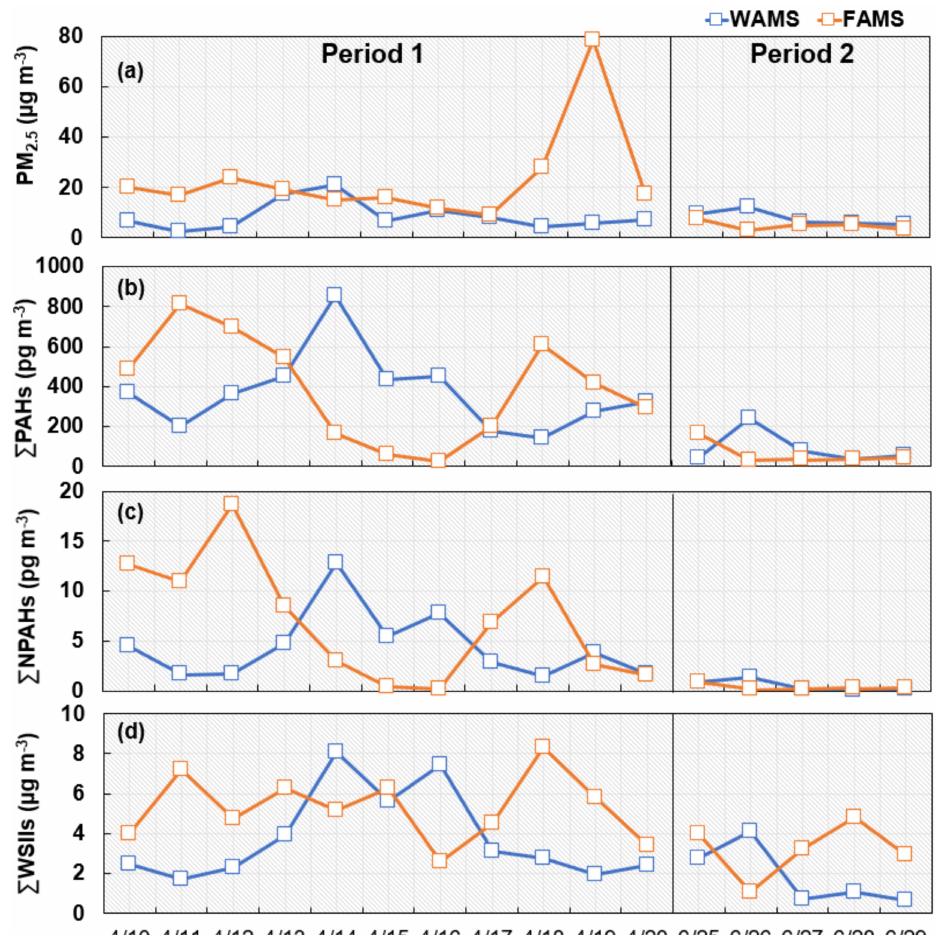
Figure 2. Concentrations of particulate matter with aerodynamic diameter ≤ 2.5 µ m (PM 2.5 ) ( a ), (cid:80) (cid:80) total polyaromatic hydrocarbons ( PAHs) ( b ), total nitro-PAHs ( NPAHs) ( c ), and total water-soluble (cid:80) inorganic ions ( WSIIs) ( d ) at WAMS and FAMS in the East Asian winter monsoon period (Period 1, 10–20 April 2017) and summer monsoon period (Period 2, 25–29 June